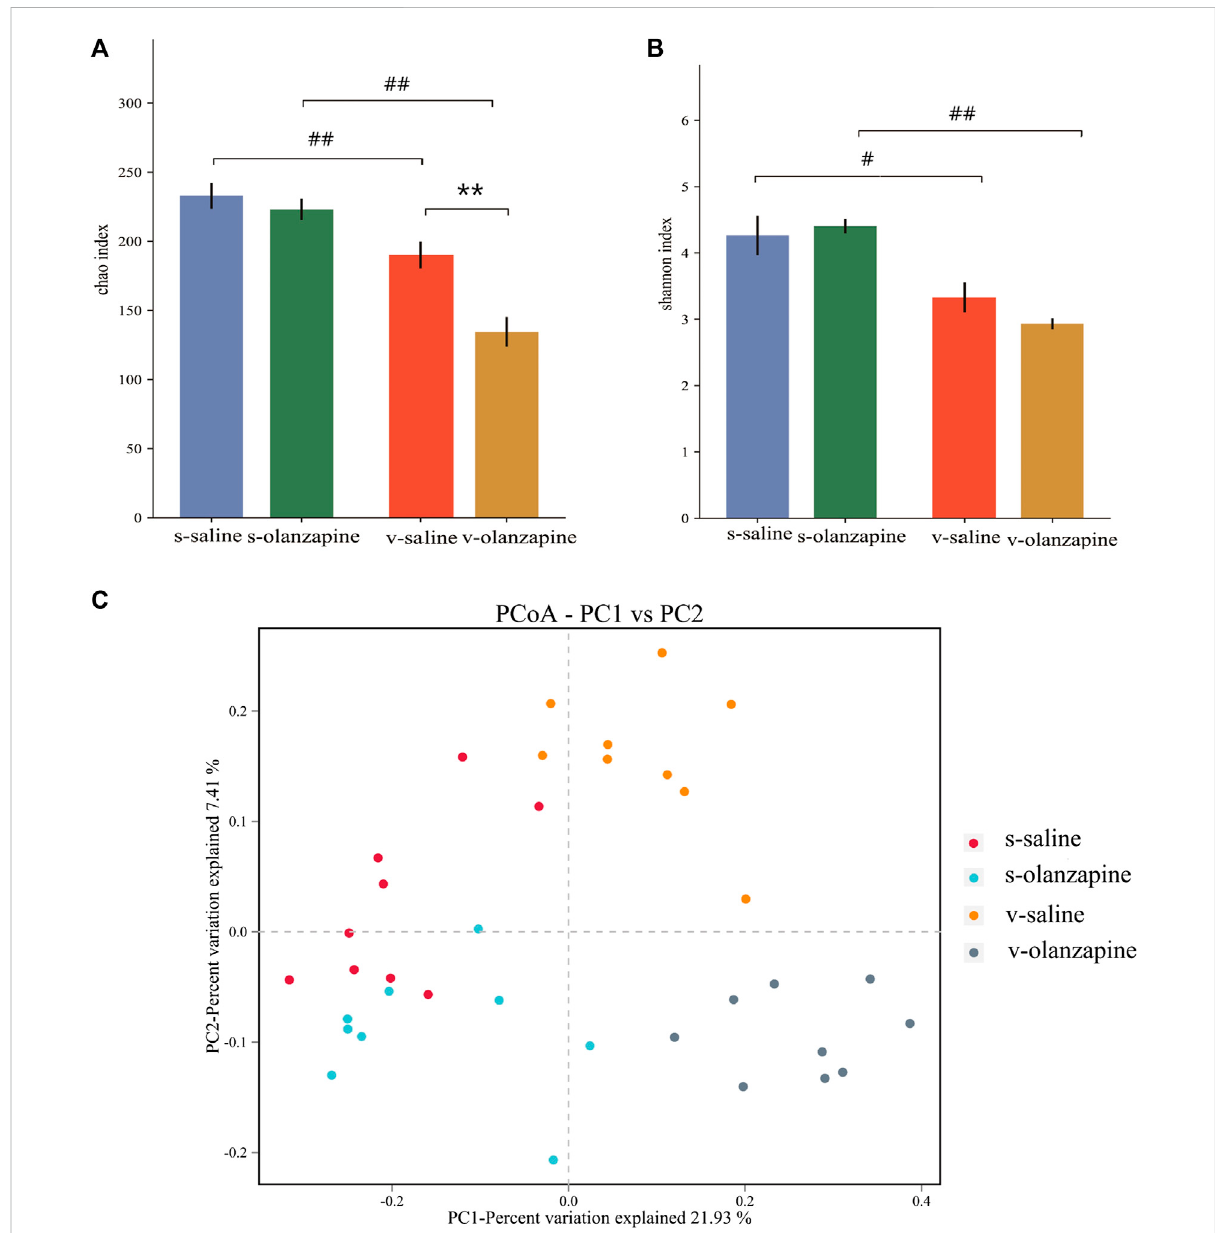
FIGURE 2 The results of species diversity analyses (OTU levels; ** p < 0.01; # p < 0.05 and ## p < 0.01) are shown among four groups as differences in the Chao1 index (A) and in the Shannon index (B) ; and (C) PCoA analysis graph illustrating group pro fi le